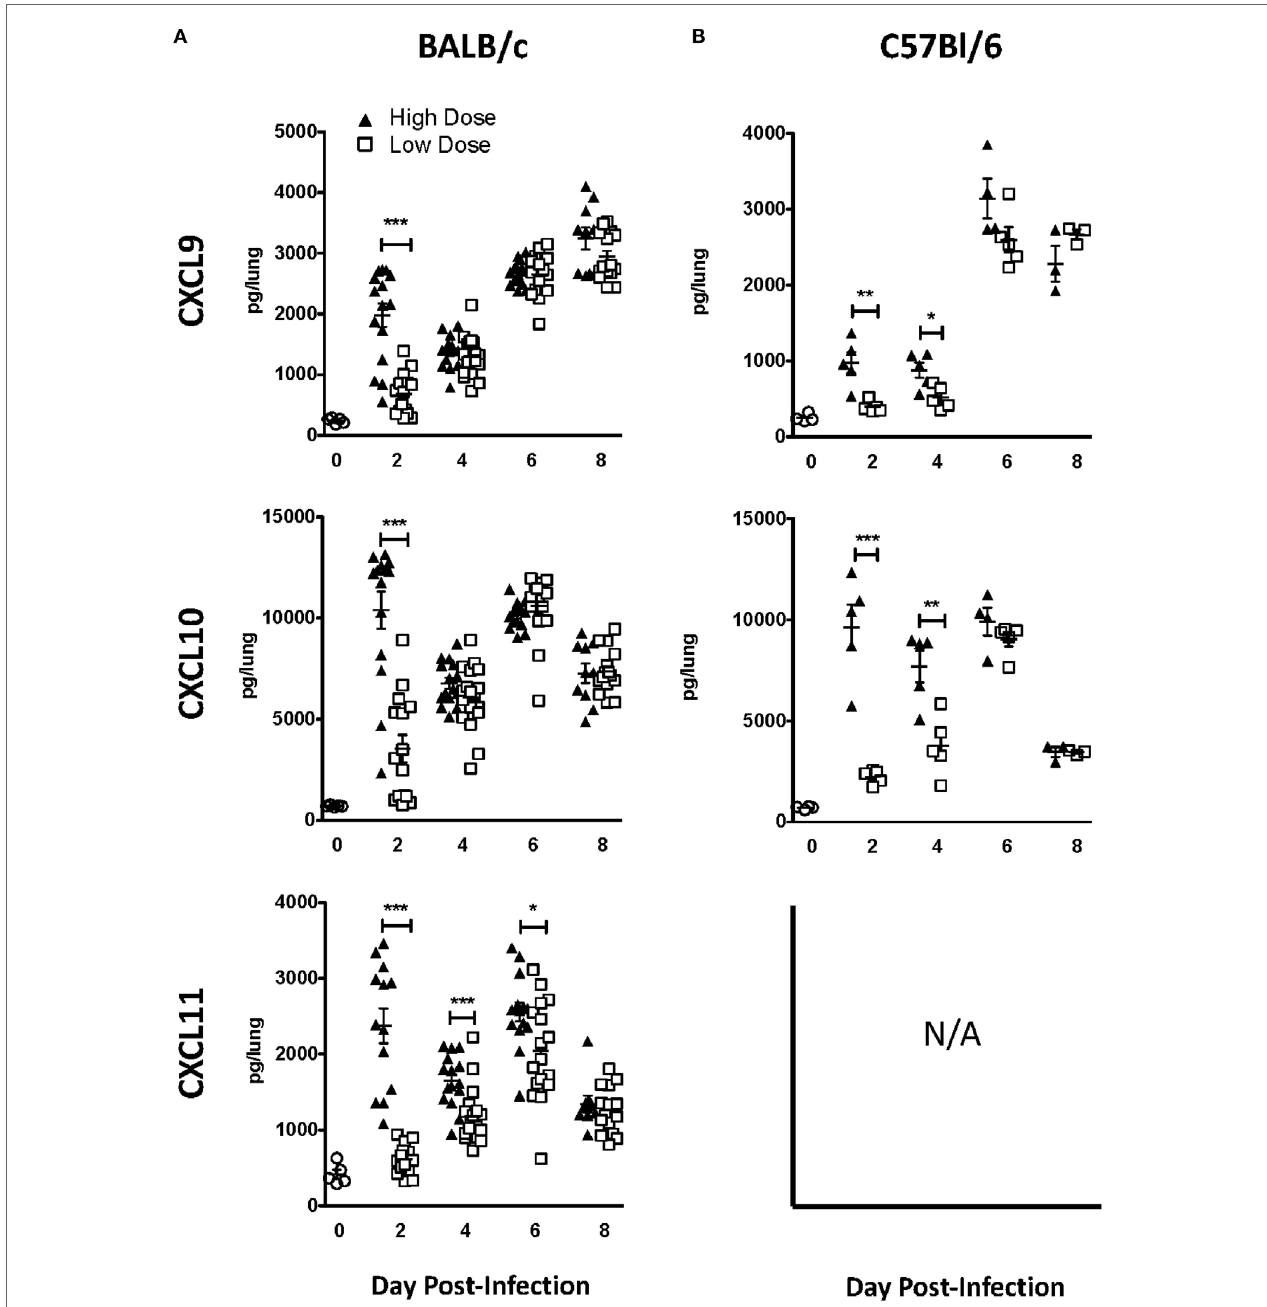
FigUre 6 | CXCR3 ligands are upregulated in the lungs during influenza A virus (IAV) infection and expressed at higher levels in the lungs of high-dose-infected mice. (a) BALB/c and (B) C57Bl/6 mice were infected with either a high- or low-dose IAV. Lungs were homogenized, and the levels of CXCL9, CXCL10, and CXCL11 [not expressed (N/A) in C57Bl/6 mice] were quantified by ELISA. p -values comparing chemokine levels in high- vs. low-dose IAV-infected mice are shown. * p < 0.05, ** p < 0.005, *** p < 0.001 (two-tailed unpaired Student’s t -test). BALB/c data are pooled from two separate experiments with at least five mice per group. C57Bl/6 data are representative of one experiment with at least three mice per